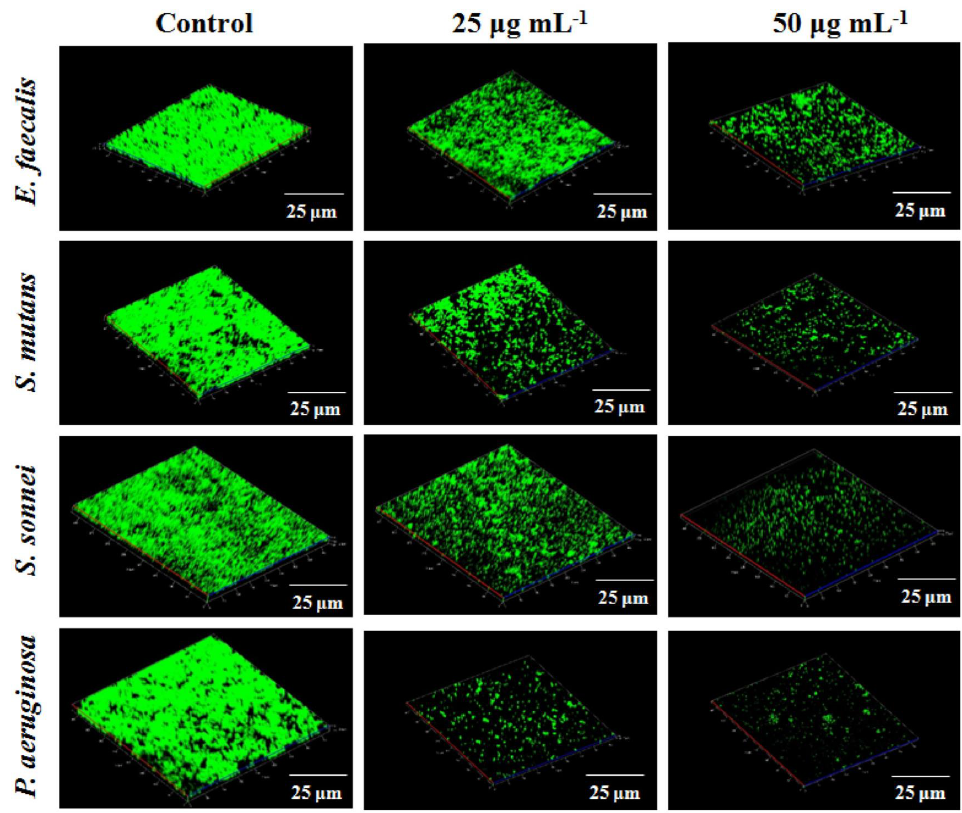
Figure 9. Confocal laser scanning microscopy images of antibiofilm activity of biogenic SeNPs, pro- duced using the aqueous extract of Murraya koenigii against Gram-positive ( E. faecalis and S. mutans ) and Gram-negative ( S. sonnei and P. aeruginosa ) bacteria. Reproduced with permission from Ref. [109] . 2019, Elsevier. Owing to their interactions with DNA and proteins, biogenic SeNPs totally inhibit S.